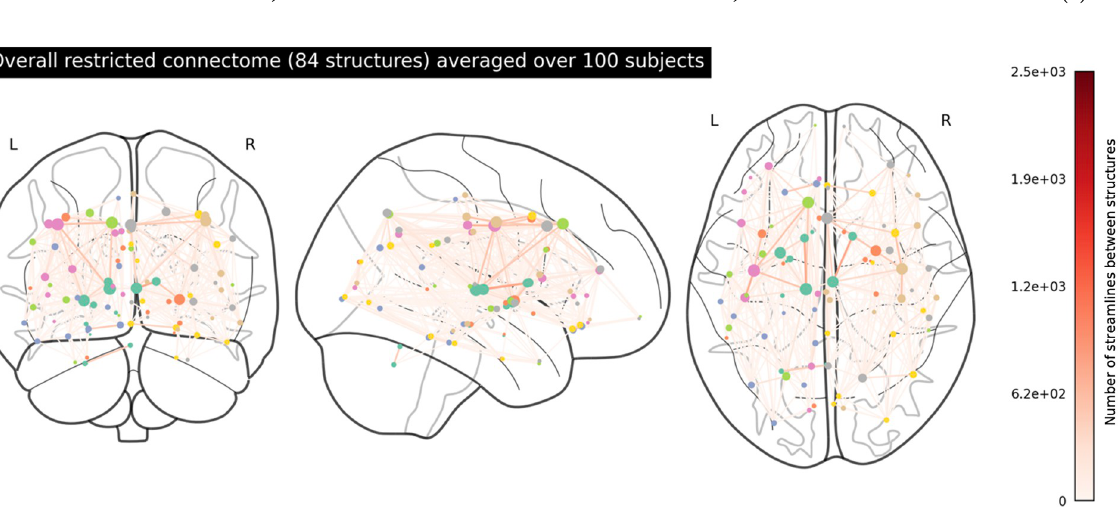
Fig 2. An overarching connectome featuring the 84 structures in the restricted network. The full list of the 84 structures in this connectome can be found in S1 Table.